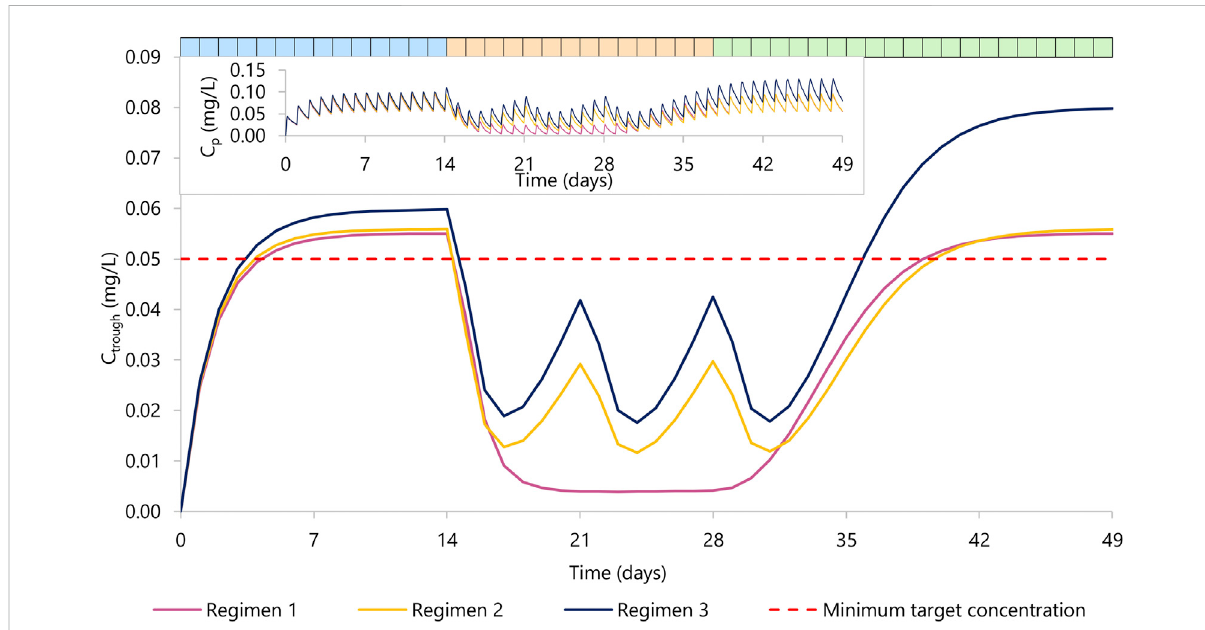
FIGURE 2 Rilpivirine C trough concentration over time. Regimen 1 (violet) represents 14 days of rilpivirine 25 mg daily dose (period one in blue), 14 days of rilpivirine 25 mg daily dose with rifapentine 600 mg daily dose (period two in orange), and 21 days of rilpivirine 25 mg daily dose (period three in green).Regimen2(yellow)represents14 daysofrilpivirine25 mgdailydose(period1),14 daysofrilpivirine25 mgdailydosewithrifapentine900 mg weekly dose, a total of three doses) (period 2), and 21 days of rilpivirine 25 mg daily dose (period 3). Regimen 3 (dark blue) represents 14 days of rilpivirine25 mgdailydose(period1),14 daysofrilpivirine50 mgdailydosewithrifapentine900 mgweeklydoseatotalofthreedoses(period2),and 21 days of rilpivirine 50 mg daily dose (period 3). The red dashed line represents the minimum target concentration for rilpivirine. The top left corner contains the mean plasma concentration PK pro fi le for rilpivirine for each regimen.